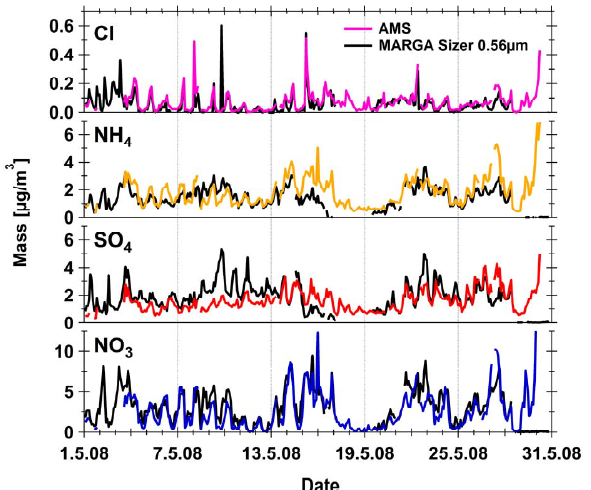
Fig. 5. Comparison of AMS chemical composition with MARGA Figure 5: Comparison of AMS chemical composition with MARGA sizer data for the 3 sizer data for the May 2008 intensive campaign. AMS data are com- May 2008 intensive campaign. AMS data are compared to MARGA 0.56 µm channel with 4 pared to MARGA 0.56µm channel with good agreement in terms good agreement in terms of both absolute mass concentration and relative trends. 5 of both absolute mass concentration and relative